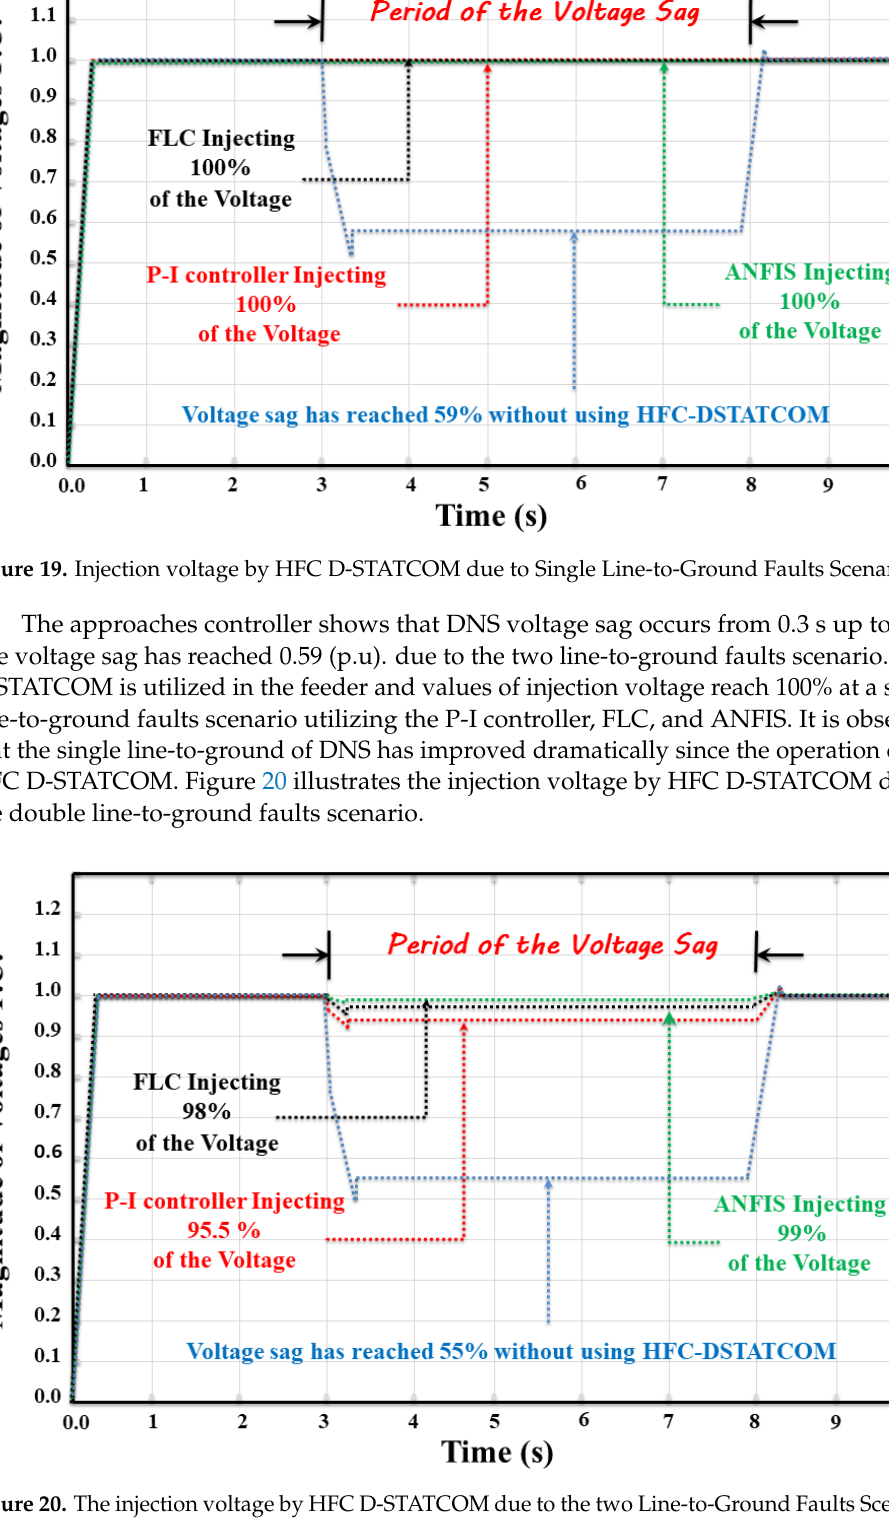
values of injection voltage reach 96% at double line-to-ground faults scenario. The double line-to-ground of DNS has improved significantly since the high performance of the HFC D-STATCOM. Figure 21 illustrates the injection voltage by HFC D-STATCOM due to the three line-to-ground faults scenario.